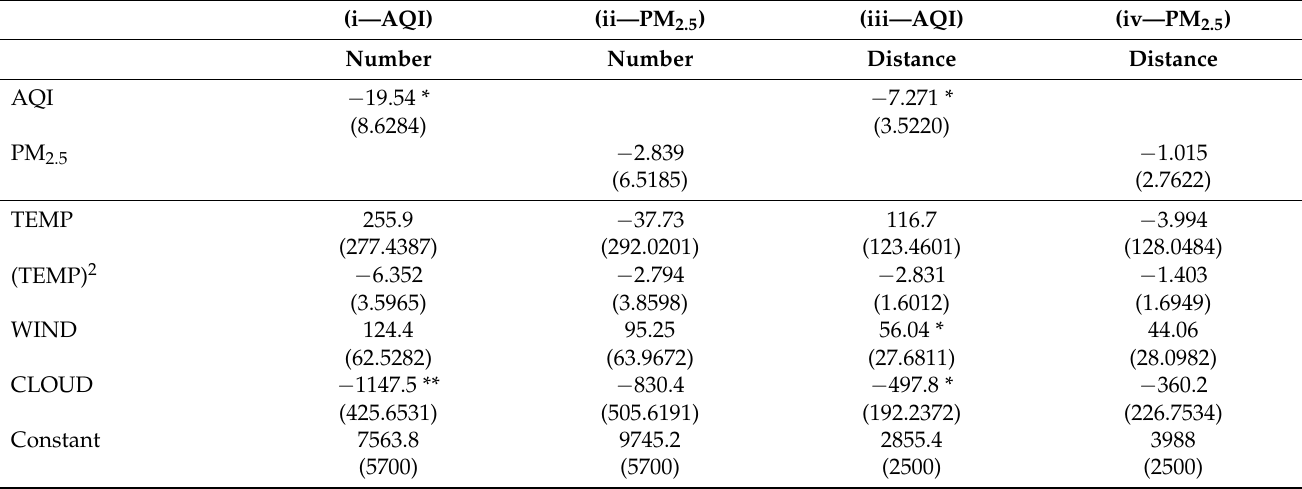
Table A17. Estimations of the effects of air pollution on people bike